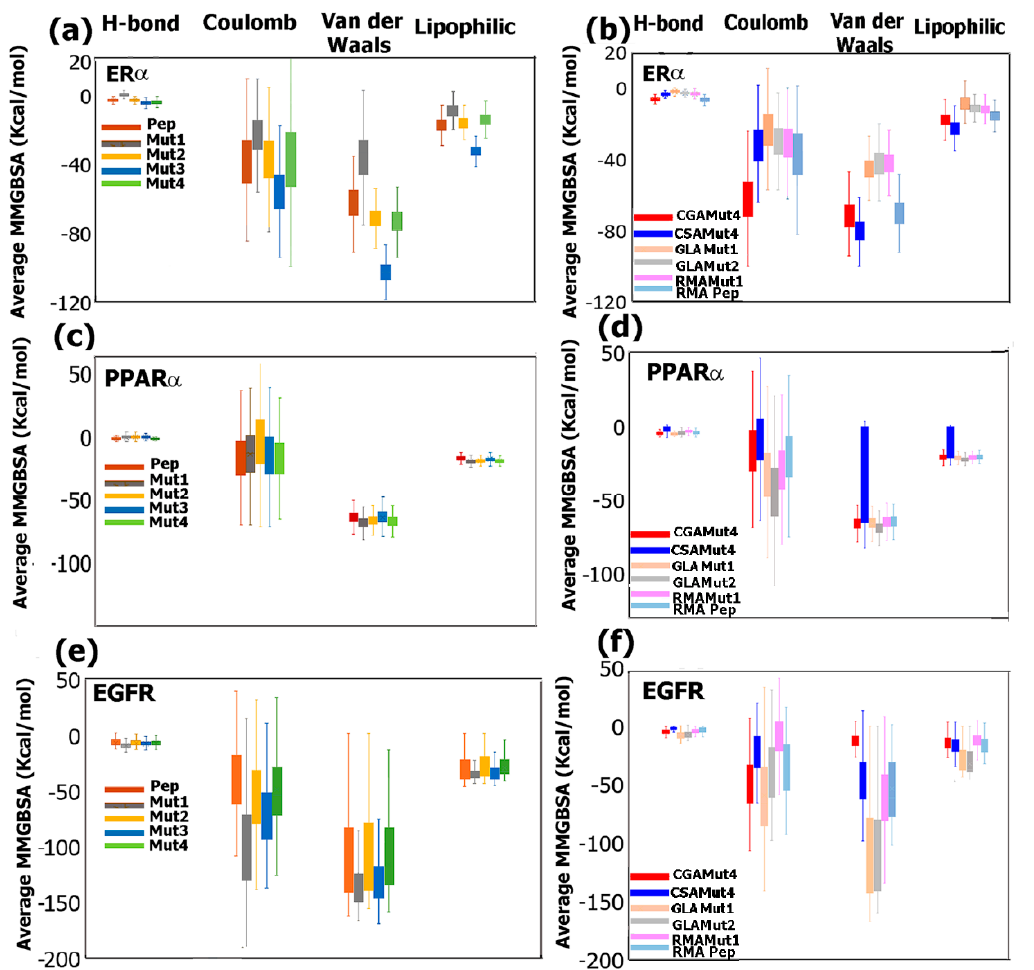
Figure 15. Comparison of Δ G binding interactions based on MMGBSA calculations. H-bonding, coulomb interactions, van der Waals and lipophilic contributions are shown. ( a , c , e ) show interactions involving the peptides (Pep, and mutated peptides) while ( b , d , f ) show the interactions with the polyphenol-conjugates of the peptides with ER α , PPAR α and EGFR respectively.